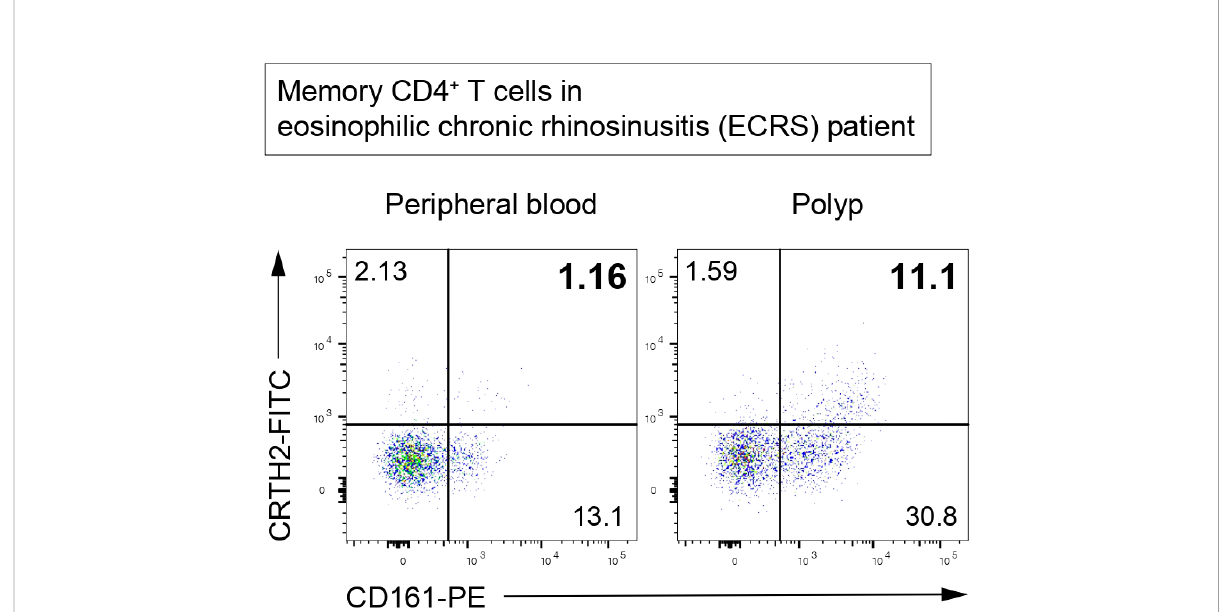
FIGURE 5 Memory-type Tpath2 cells in an ECRS patient. Representative plots of CD4 + CD45RO + (memory CD4 + ) T cells isolated from the peripheral blood and polyp of an ECRS patient. CRTH2-positive and CD161-positive cells are de fi ned as Tpath2 cells